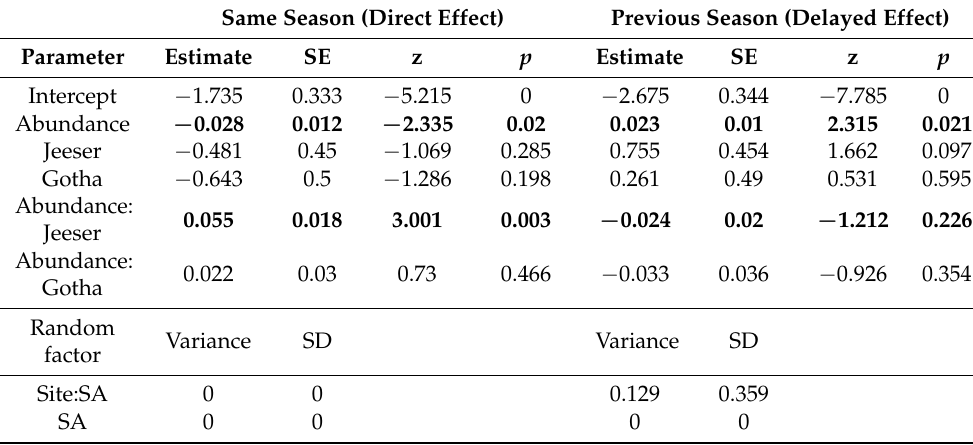
Table 2. Direct and delayed effects of common vole abundance (as index) in interaction with study area (SA) on TULV seroprevalence in the host population. The categorical factor contained three levels with Weissach as the reference category. Number of observations each = 43, degrees of freedom each = 6. Bold values indicate significance of p value ( p < 0.05). SE = standard error; SD = standard deviation; z = Wald statistics defined as